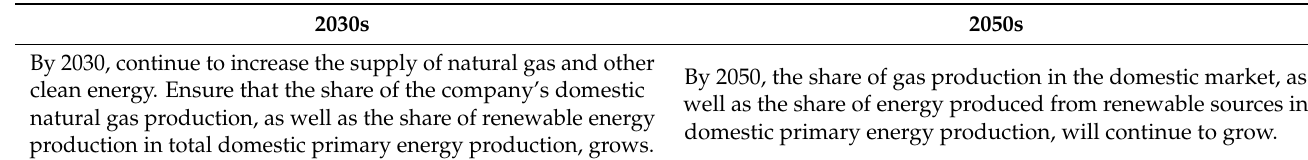
Table 7. PetroChina’s low-carbon development plans.